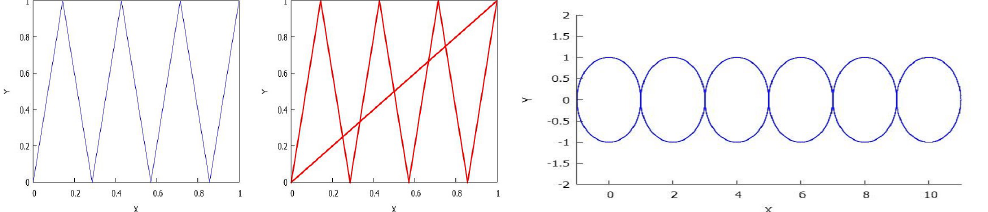
(( x )) homeomorphic to C 0 , x 0 6